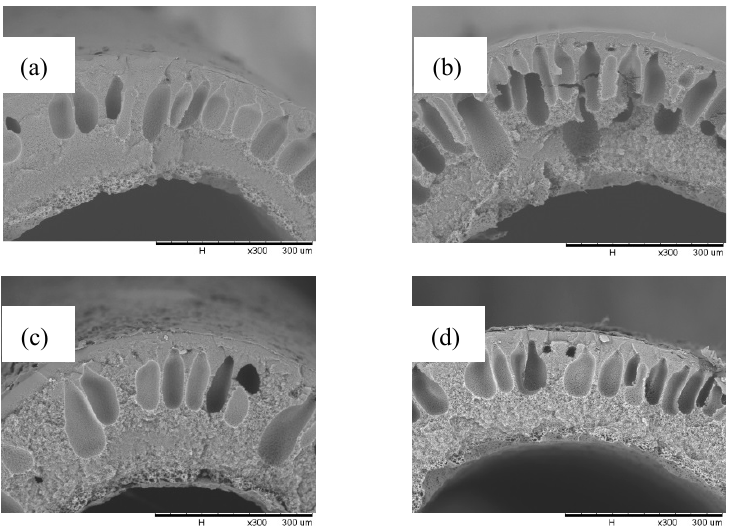
Figure 4. SEM surface morphology images for the modified membranes with the non-solvent at different concentrations: ( a ) 10 mg mL − 1 ; ( b ) 25 mg mL − 1 ; and( c ) 40 mg mL − 1 . A magnification of 150× was used for each concentration.